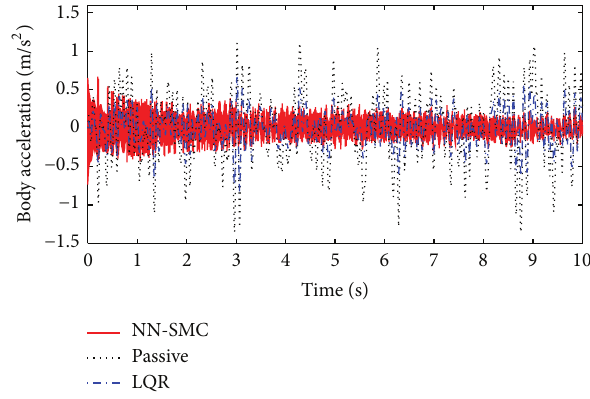
Figure 14: Body acceleration (Case